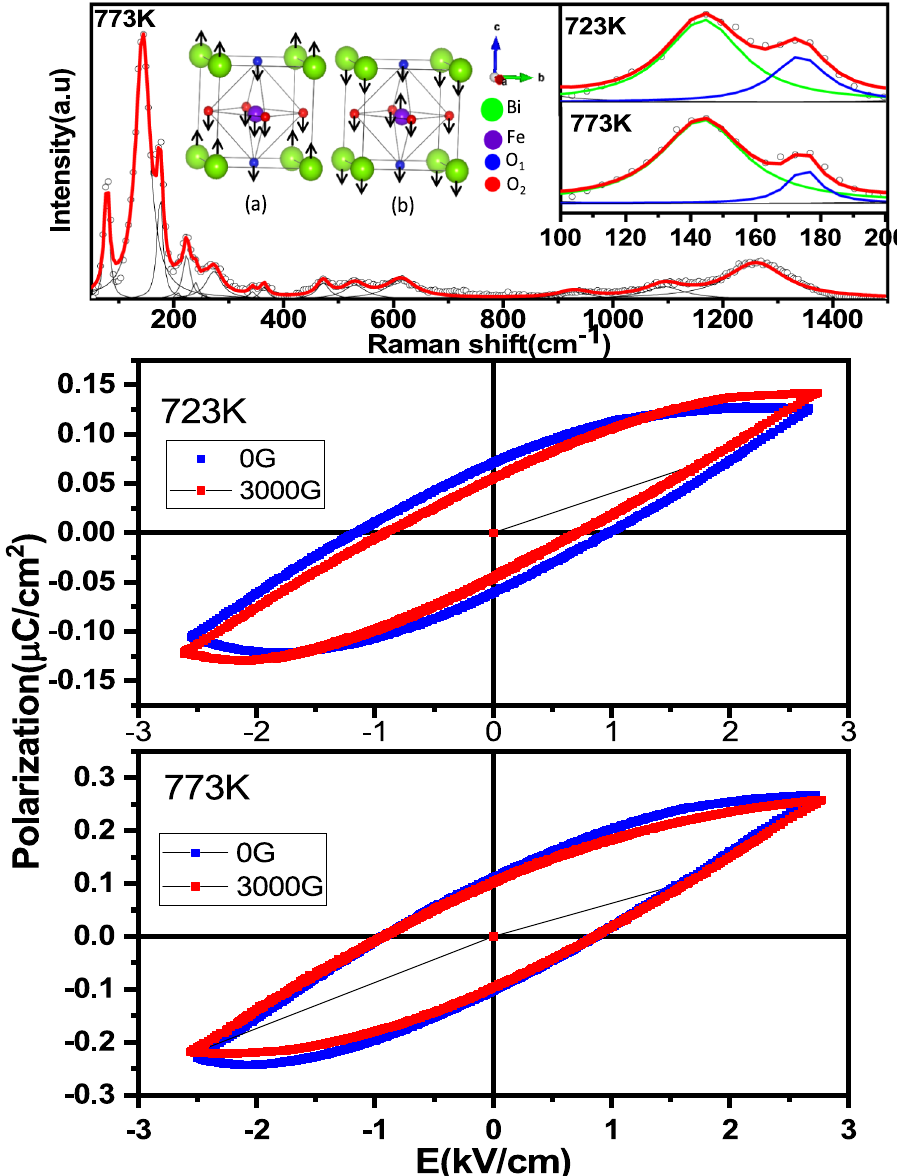
Figure 8. Effect of magneto electric coupling at 300 K in the precursor gel subjected to calcination treatments for 2 h at ( a ) 723 K, ( b ) 773